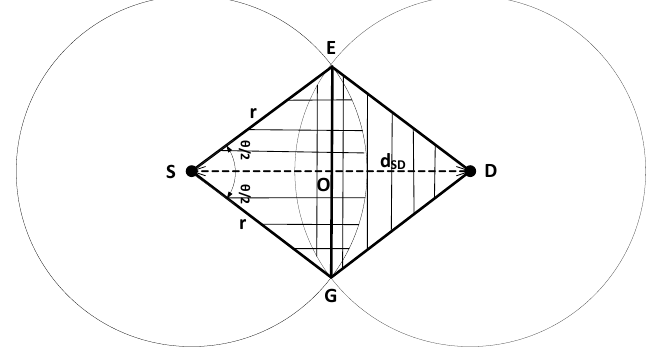
Figure A1. Area of overlapping